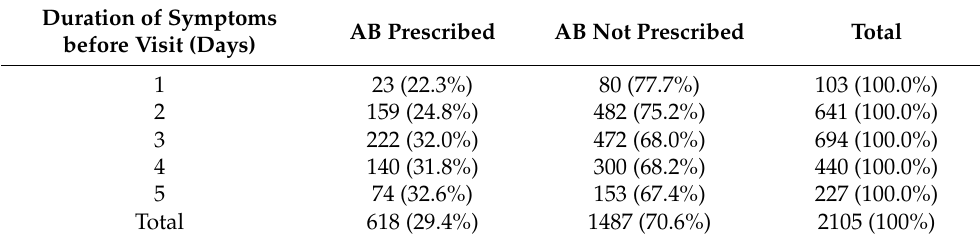
Table 4. Proportions of antibiotic (AB) prescriptions, relative to the duration of symptoms. Duration of